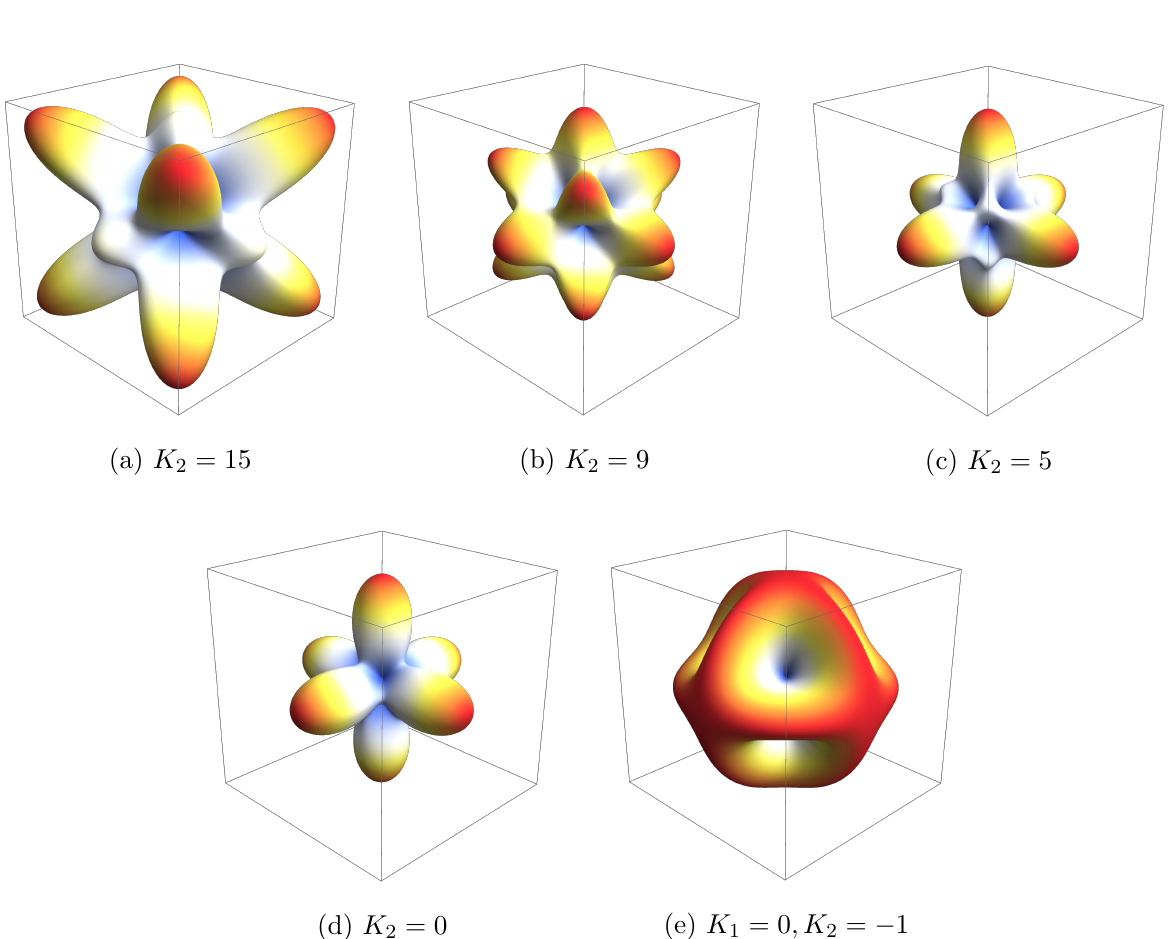
Fig. 2. Colour coded spherical plot (created with the software Wolfram Mathematica) of the magnitude of the shifted free energy density ε . The (here for simplicity unitless) value K 1 was always equal to − 1 , except for the bottom right image (e), where K 1 = 0 was